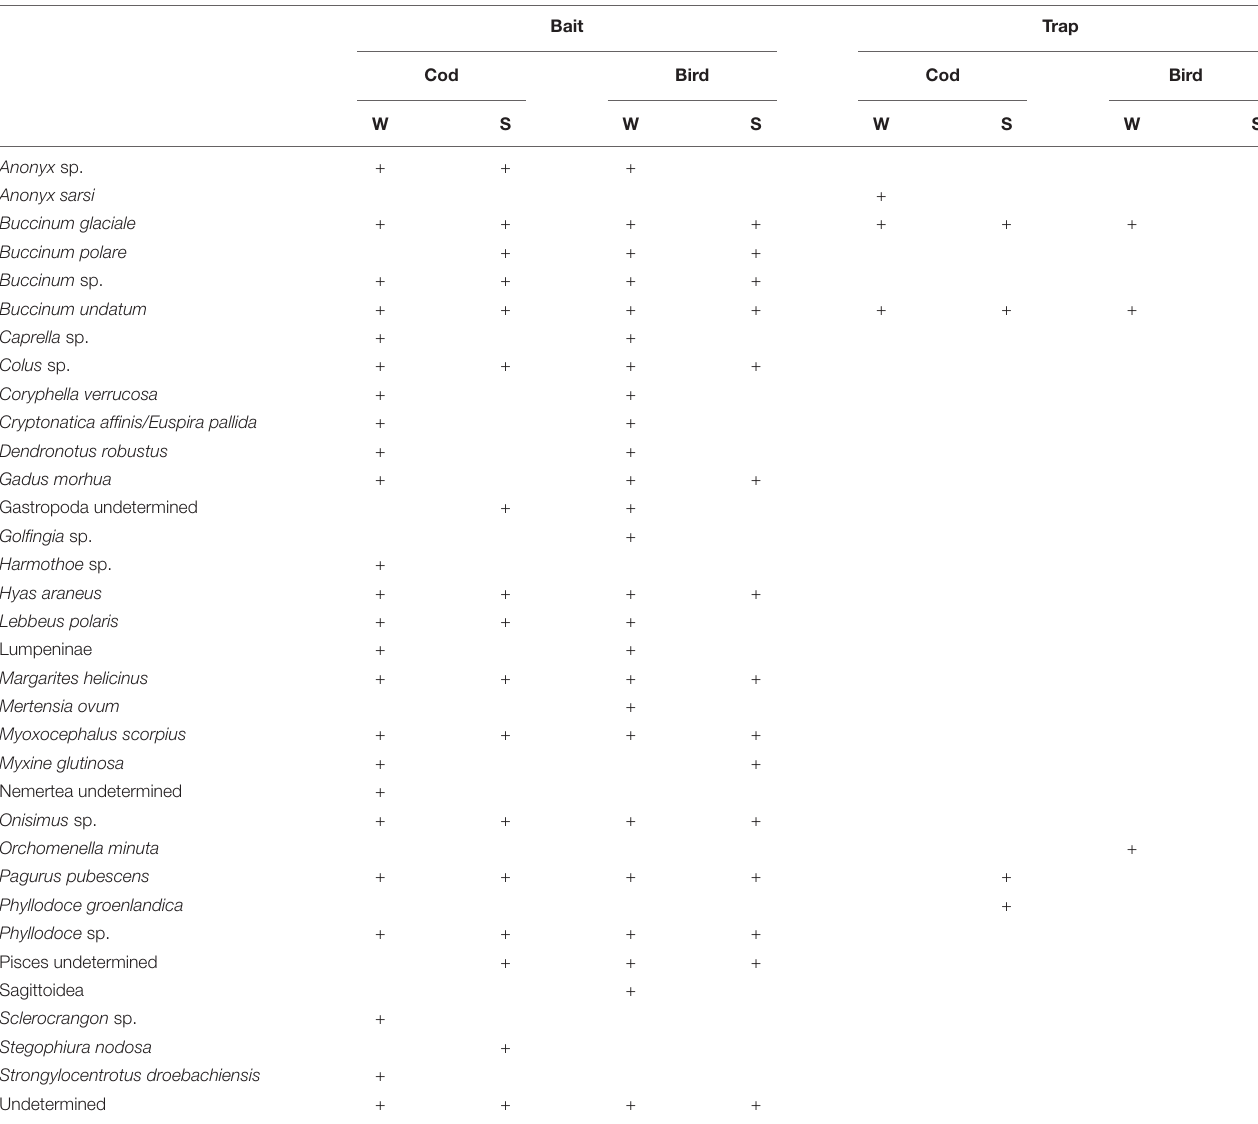
TABLE 2 | List of taxa occurring on different bait types on photographs and in traps (W-Winter, S-Summer). Bait Trap Cod Bird Cod